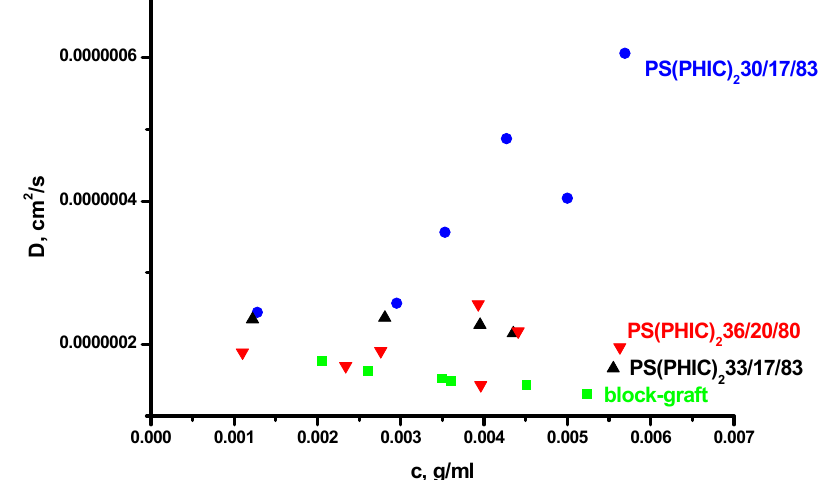
Figure 7. DLS plots of the miktoarm star and the block-graft copolymers in n-heptane.